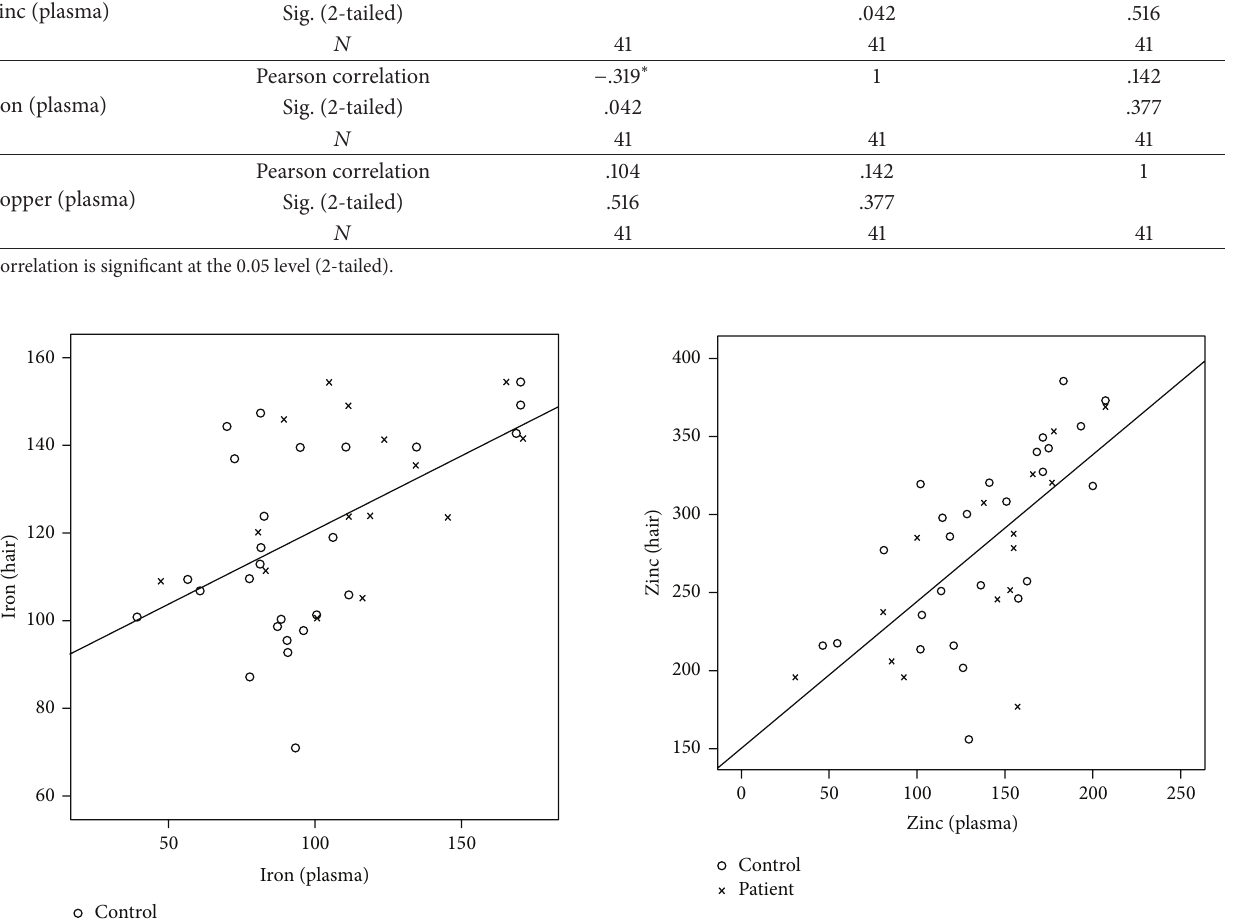
Figure 2: Correlation between plasma and hair zinc level in patients and